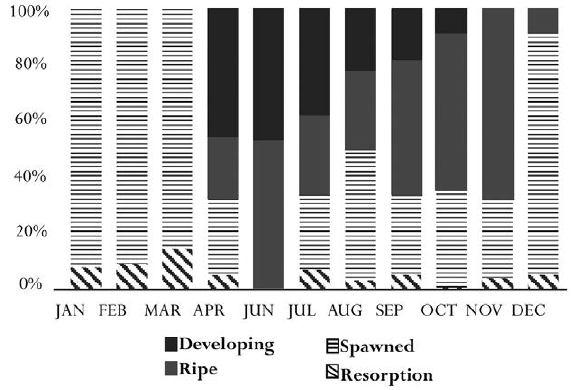
Fig. 3. – Male gonadal stages as determined from histological analy- sis . Key to bar textures: Black, developing; grey, ripe; crosshatched, spawned; diagonally hatched,